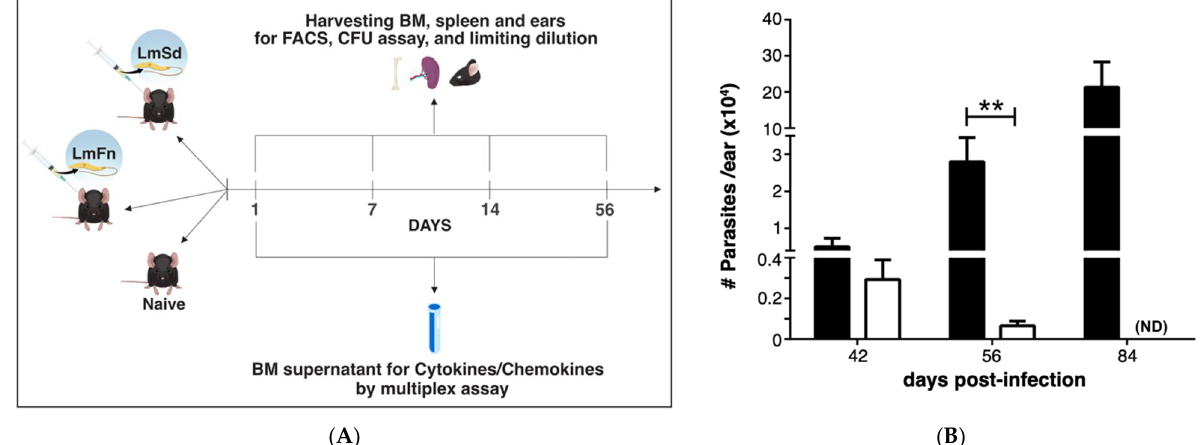
Figure 1. Lm Sd and Lm Fn infections in C57BL/6 mice: ( A ) Experimental design. C57BL/6 mice were inoculated in the ear dermis with 1 × 10 3 Lm Fn and Lm Sd metacyclic promastigotes. Bone marrow, spleen, and infected ears were analyzed on day 1, 7, 14, and 56 post-infection. FACS analysis and culture for parasite burden were performed for all times-points. Cytokine and chemokine analyses were performed on day 1 and day 56 by multiplex assay. ( B ) Parasite burden in the infected ears as determined by limiting dilution analysis (LDA) over the course of infection. No parasites were detected at earlier time points in the ear or at any time point in the bone marrow. Graph represents the mean ± SEM: n = 3, n = 10 and n = 3 mice per group ( Lm Fn vs. Lm Sd) on days 42, 56, and 84, respectively. ** p < 0.05 comparing infection with Lm Fn and Lm Sd.